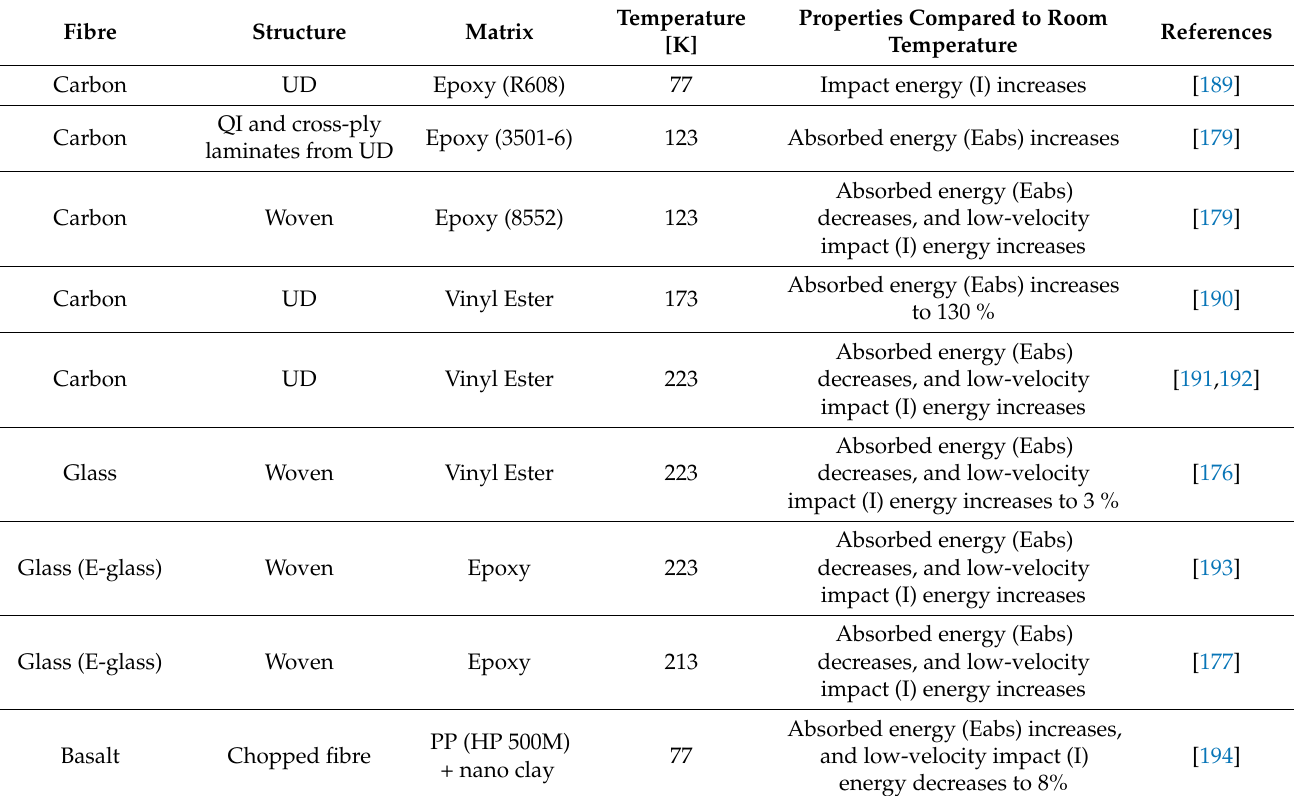
Table 7. A detailed summary of the effect of low and cryogenic temperatures on the impact behaviour of fibre-reinforced